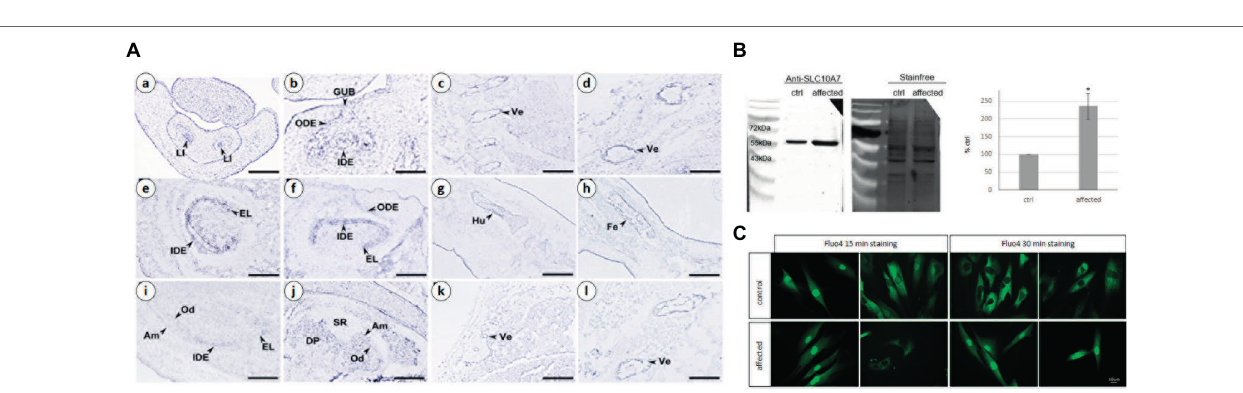
FIGURE 3 | (A) Analysis of mouse Slc10a7 transcripts distribution by in situ hybridization. Sections illustrate Slc10a7 expression in the developing bone, vertebrae, molars, and incisors. Developmental stages and section planes are: E14.5 frontal (a,b) , E16.5 sagittal (c–h) ; E18.5 sagittal (i–l) sections. Am, ameloblasts; DP, dental papila; EL, epithelial loop; GUB, gubernaculum; IDE, inner dental epithelium; LI, lower incisor; Od, odontoblasts; ODE, outer dental epithelium; SR, stellate reticulum; Ve, vertebrae. Scale bars: 10 μm (b) ; 40 μm (a,c,g,h) ; 30 μm (d,l) ; 60 μm (i,j) ; 80 μm (e,f) ; 150 μm (k) . (B) SLC10A7 expression in control and patient skin fibroblasts as detected by western blot. The stain-free membrane, displaying the total amount of protein loaded, was used for quantification. The western blot shown corresponds to one significant experiment ( n = 3). The data plotted were the mean of three independent experiments. Statistical analysis was done with the t -test and the p was determined * p < 0.05. (C) Calcium localization in control and patient fibroblasts. The cells were stained for 15 min or 30 min with 4 μm of Fluo4, then washed for 15 or 30 min, respectively and observed by fluorescent microscopy. Images were taken with a 400× magnification, scale bar 10